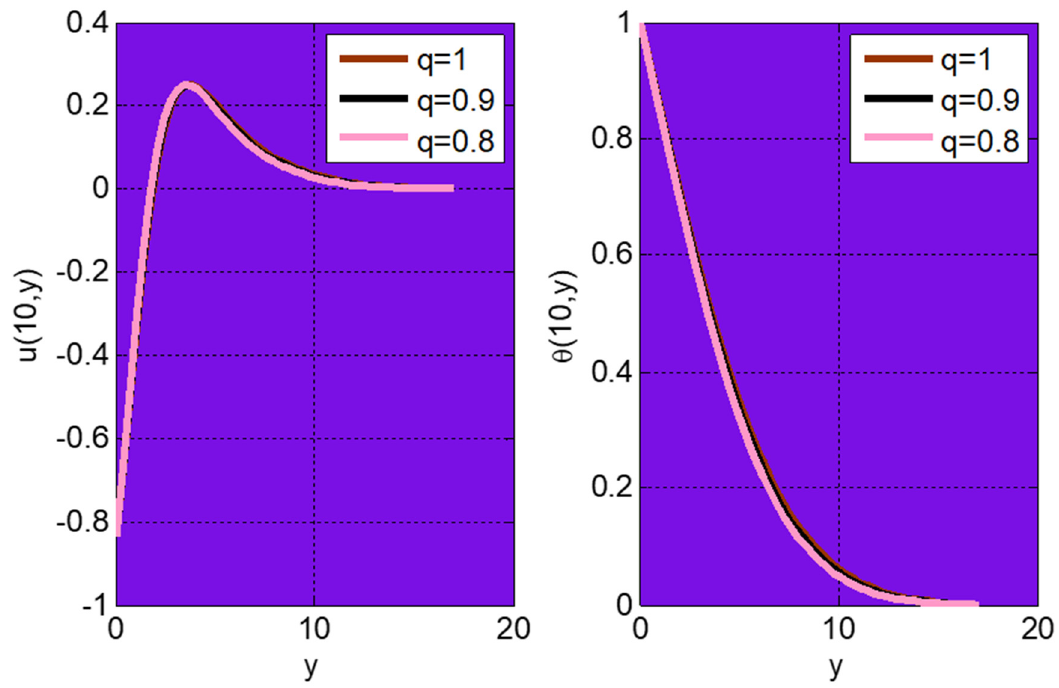
Figure 7. Impact of q on the solution of Stokes’ second problem by the proposed scheme for spatial direction and Crank–Nicolson scheme for time direction using N y = 50, N t = 500, λ = 0.09, β = 0.09, Pr = 0.7, t f =